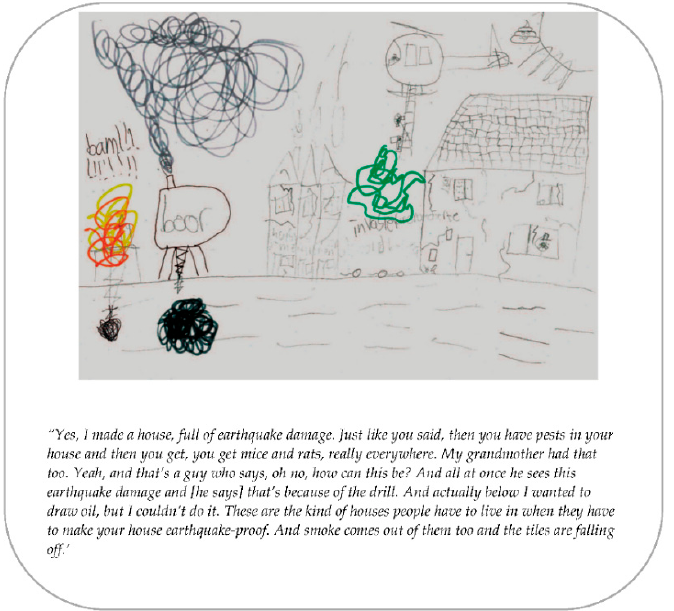
Figure 1. Drawing of a participant (12 years).